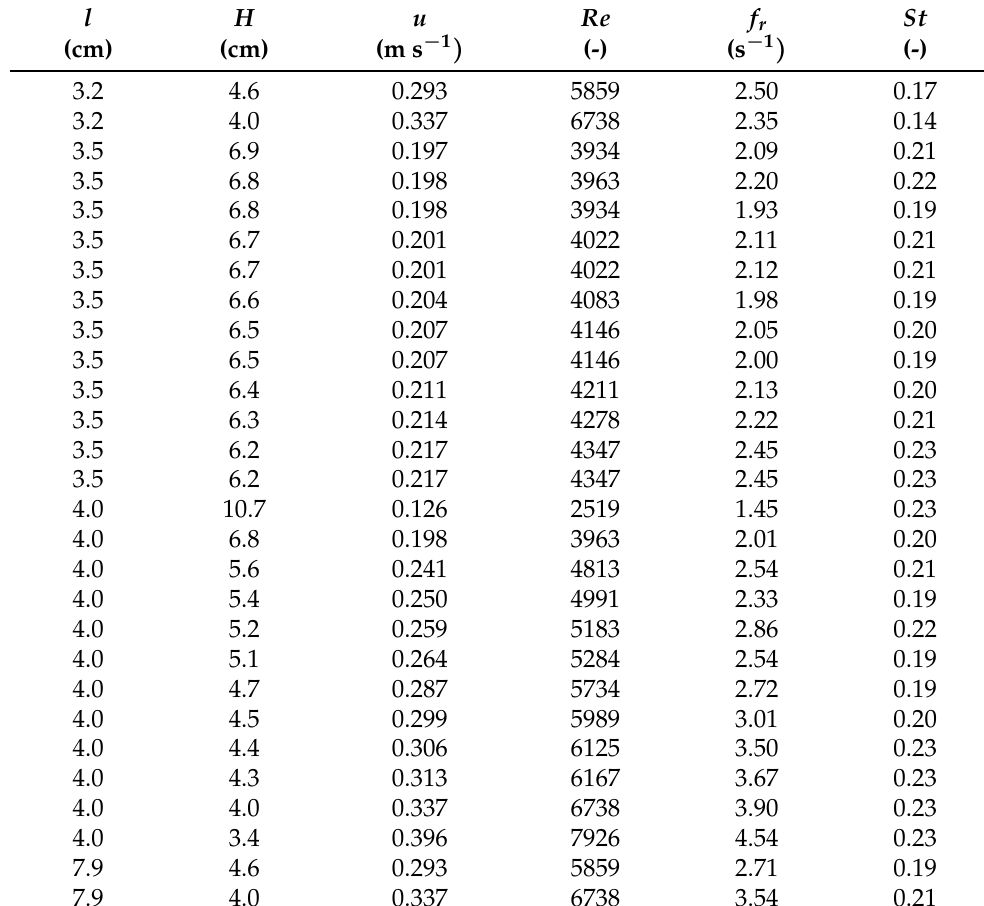
Table 2. Values of peak frequency f r of the voltage fluctuations v ( t ) and corresponding Strouhal number St for the different analyzed configurations characterized by lenght of flag l , heigth of flow h in the open channel, bulk velocity u and Reynolds number Re